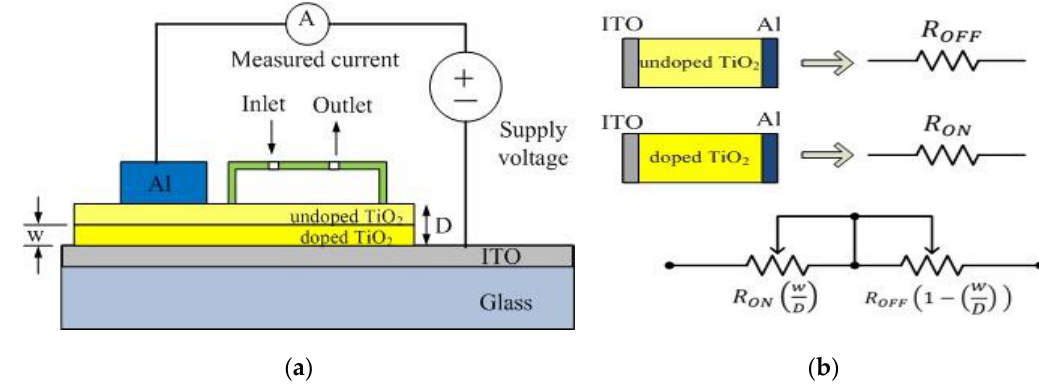
Figure 7. Current-Voltage behavior for memristor mechanism ( a ) TiO 2 layer and ( b ) equivalent circuitry.